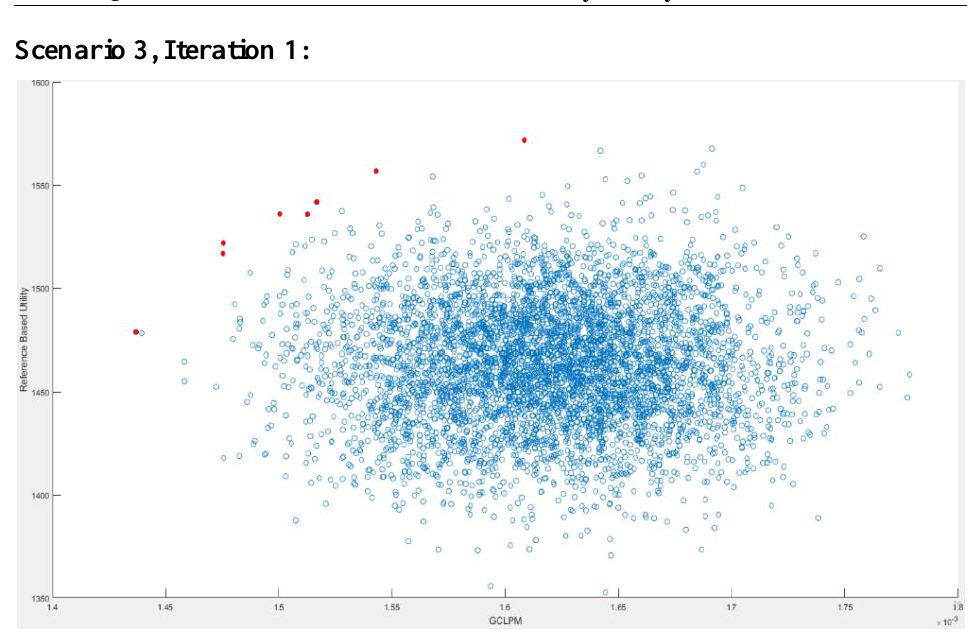
Figure 9. The Result Of Investigation Of 5,000 Different Portfolios In First Iteration Of Scenario 3